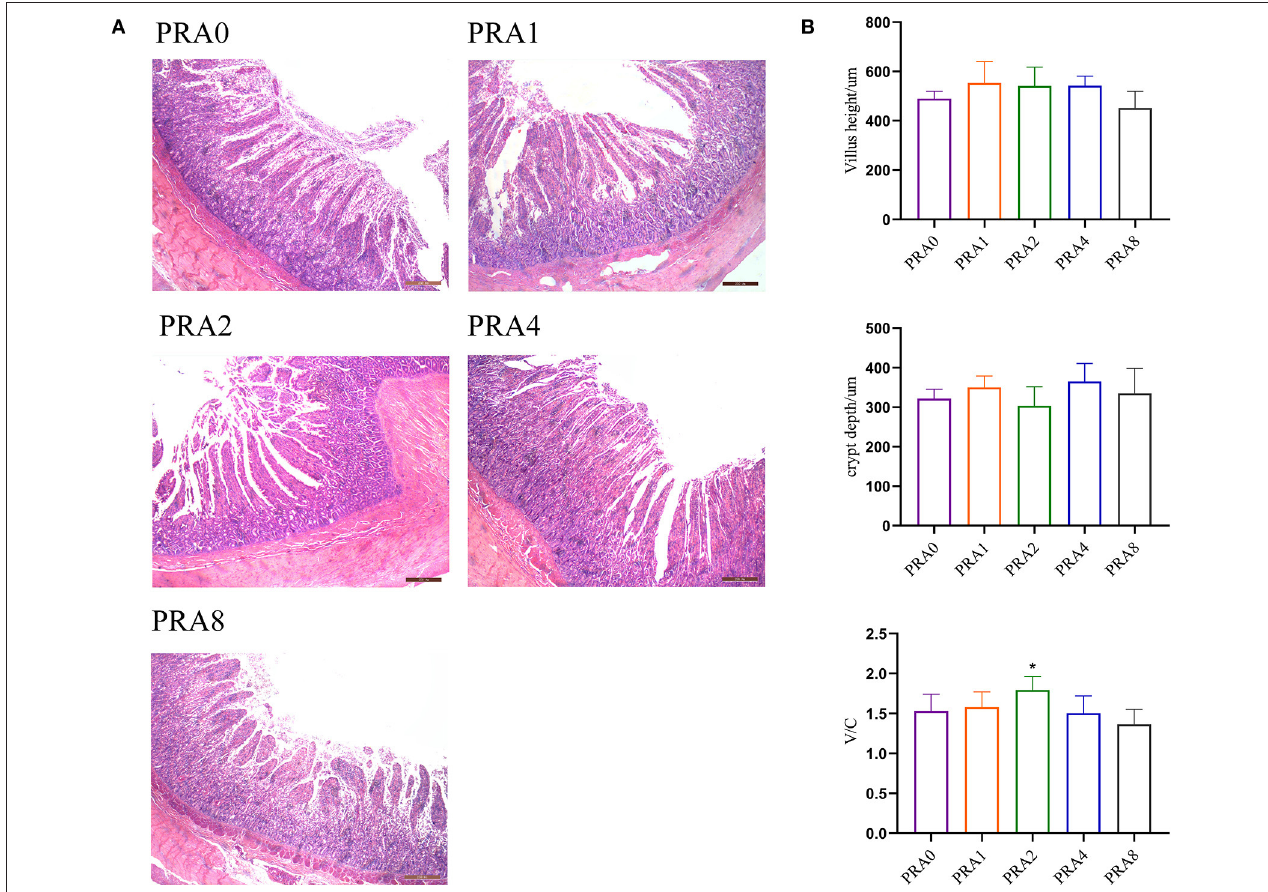
FIGURE 1 | Effects of dietary Paeoniae Radix Alba on intestinal morphology of raccoon dog. (A) HE stained sections of the small intestine (40 × ). (B) Villus height, crypt depth, and their ratio of small intestine * P < 0.05 vs. group PRA0.